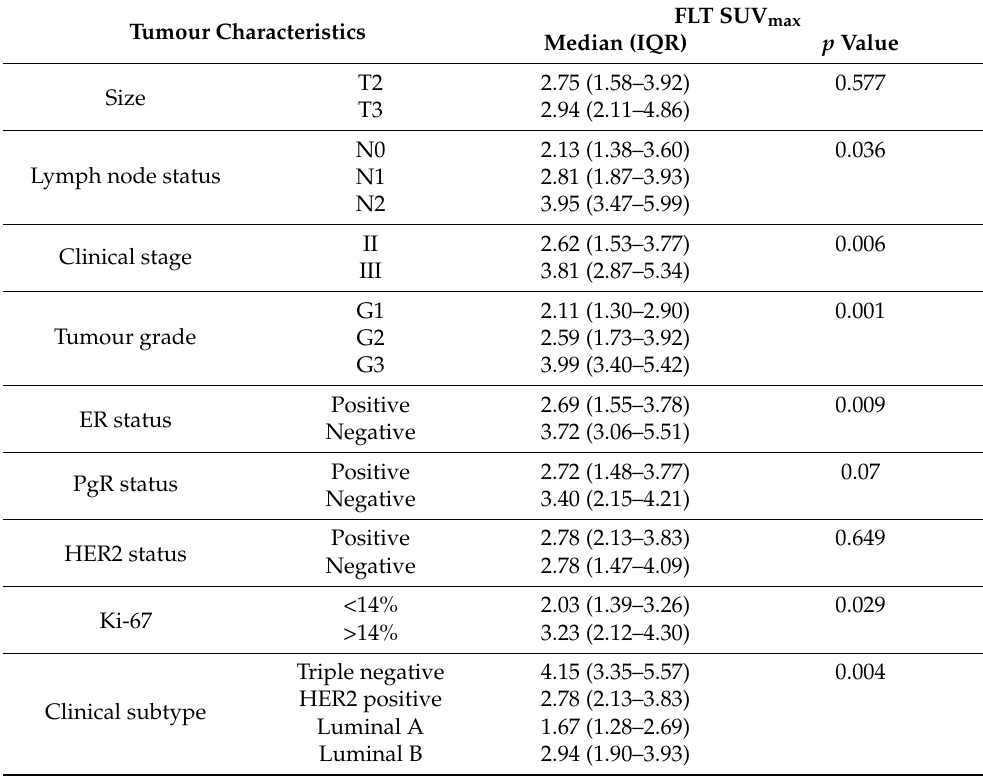
Table 2. Association between baseline clinical-pathological characteristics and FLT uptake.